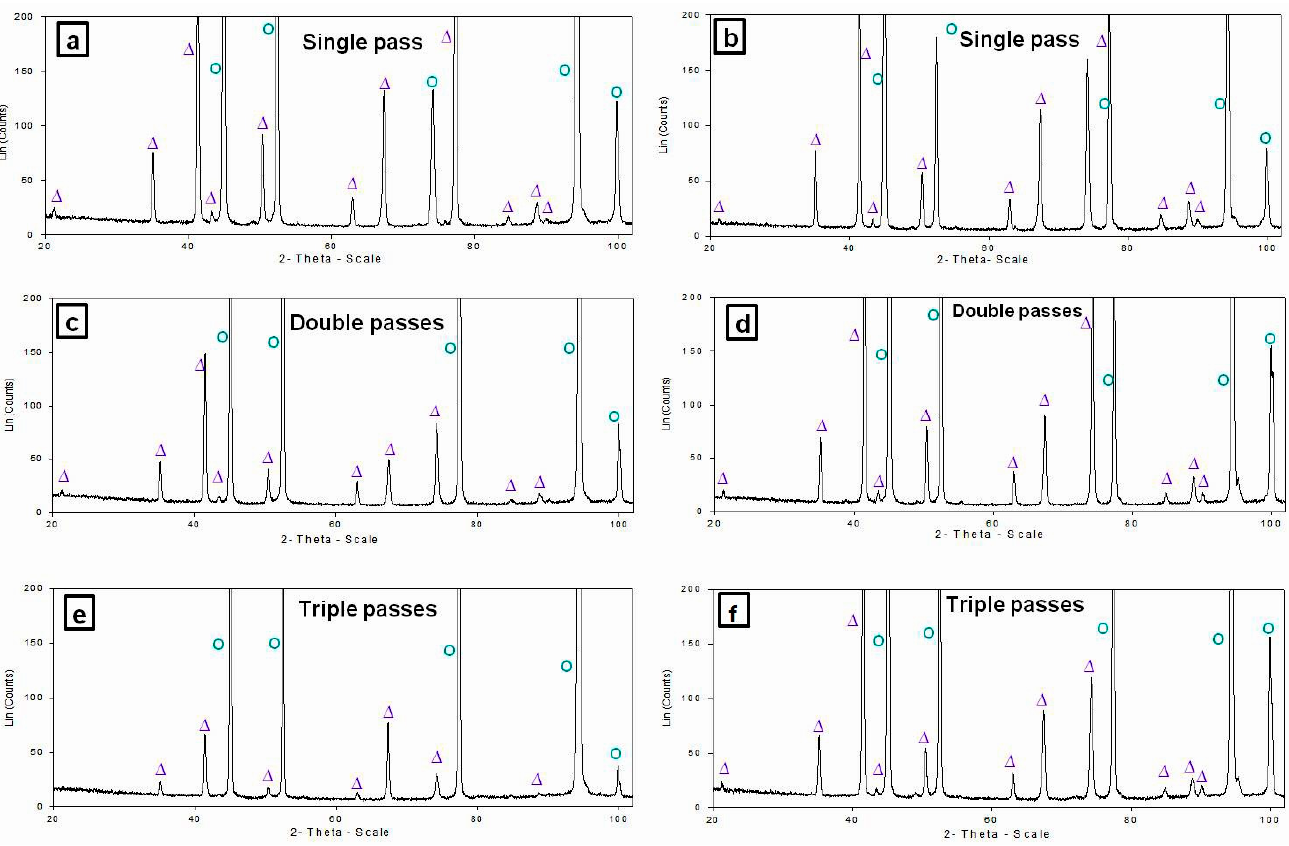
Figure 8. XRD patterns of nugget zones cross-sections (Al-Fe 3 O 4 ) after single, double and triple FSP passes at rotation speeds of 1500 rpm ( a , c , e ) and 2000 rpm ( b , d , f ) ( Al and ∆ Fe 3 O 4 (cid:35)